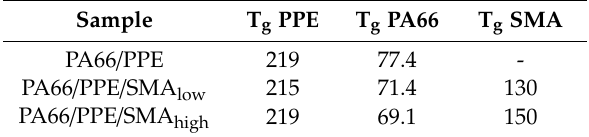
Table 2. Glass transition temperatures of PPE (tan δ maximum) for reference and 10 wt% SMA contents.